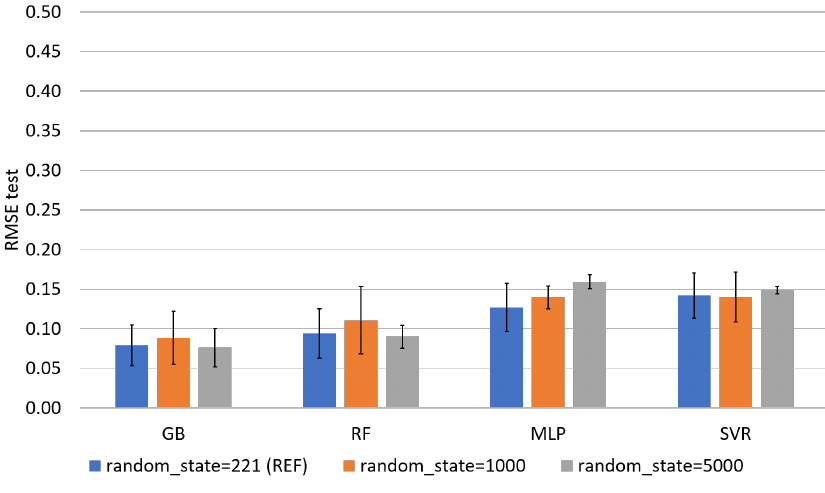
Figure E4. Random state impact on test RMSE, without HP